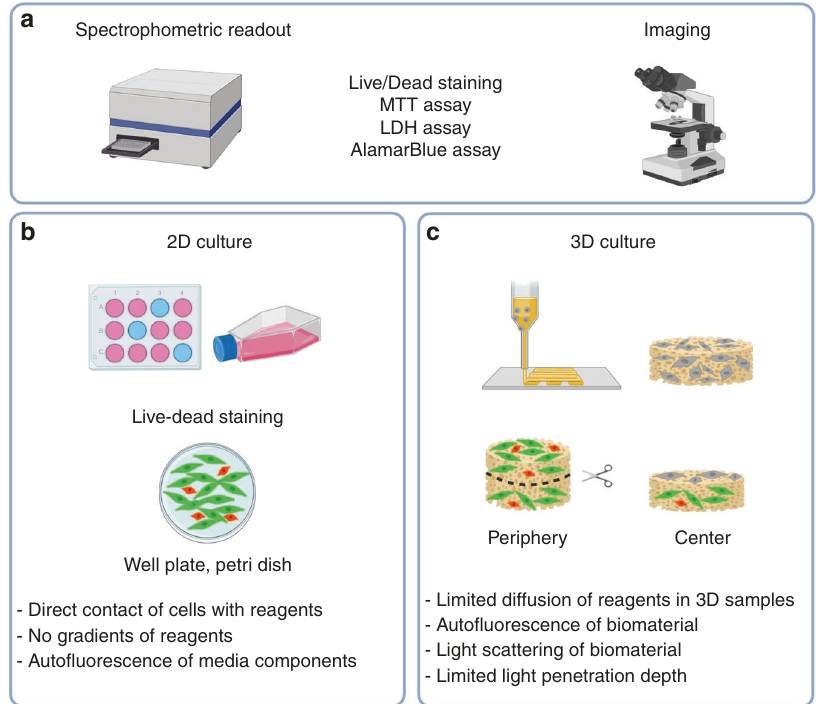
Fig. 1 Analysis of cell viability in 2D and 3D cultures. a Comparison of viability and metabolic activity assessment via spectrophotometric readouts or (confocal) microscopy in 2D and 3D in vitro culture setups. b 2D cultures are shown as monolayers in well plates or tissue culture fl asks where reagents have direct contact with the cells. c 3D samples are characterized by the presence of a biomaterial as a supportive structure (e.g., fabricated via 3D bioprinting) in which the cells are embedded. Reagents need to diffuse through the material to stain or be metabolized by the cells, and thus, a limitation in penetration depth may result in low or no positive staining toward the center of the 3D construct, as illustrated for live-dead staining. Furthermore, many biomaterials or compounds present in the materials can interfere and show an auto fl uorescent signal that, in the worst case, results in higher readout values or background staining than that derived from the cells assessment of cell viability in 3D tissue engineered constructs. It is crucial to follow speci fi c assay conditions. Details on the procedures in the preparation of samples are reported in part ISO 10993-12:2012(E). For example, in the extract test method, extracting conditions should simulate the clinical use conditions without altering the chemical properties of the samples. According to ISO 10993, a reduction in cell viability by more than 30% is considered to be a cytotoxic effect. This cellular toxicity can be determined following different evaluation cate- gories: assessment of cell damage by morphological means, measurement of cell growth, and measurement of speci fi c aspects of cellular metabolism. Additional qualitative morphological scoring is available to assess changes in the general morphology, vacuolization, detachment, cell lysis and membrane integrity. One of the most common cytotoxicity tests is the (3-(4,5- In addition to the evaluation of the cytotoxicity of the compounds connected to ISO 10993, there are various other methodologies to monitor cell viability and metabolic activity in 2D and 3D culture setups, including live-dead staining and lactate dehydrogenase (LDH) assays (Fig. 1). To date, the abovementioned methodologies, based on spectrophotometric or imaged-based readouts, have been estab- lished and are routinely used in 2D cultures where the reagents are applied on cell monolayers and are thus in direct contact with the cells. The main difference between 2D and 3D cultures is that in 3D cultures, the cells are embedded within a biomaterial or seeded onto a 3D scaffold. Reagent-based assays to assess cell viability or differentiation have some limitations when cells are embedded in a 3D material: on the one hand, materials may